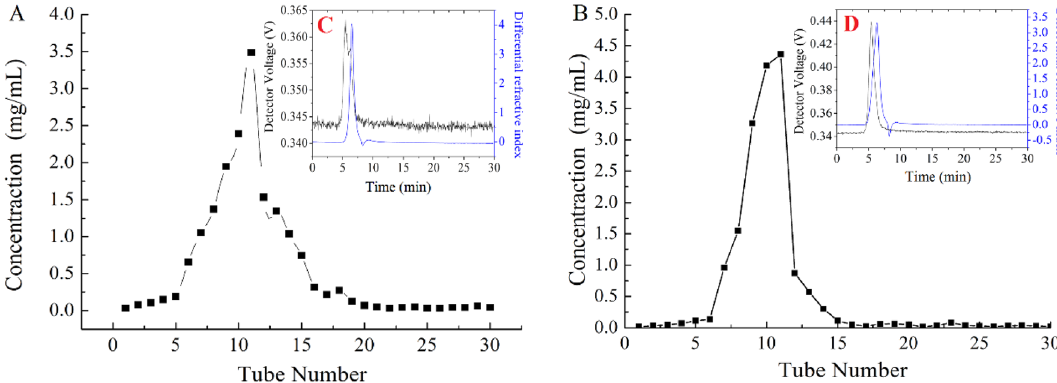
Figure 1. Elution profiles and molecular weight distributions of HNCP3 and UNCP4 purified by DEAE-52 cellulose column and Sephadex G-100 column. ( A ): The elution curve of HNCP3 purified by Sephadex G100; ( B ): The elution curve of UNCP4 purified by Sephadex G100; ( C ): Molecular weight distributions of HNCP3 by high-performance liquid chromatography coupled with multi-angle laser light scattering determination; ( D ):